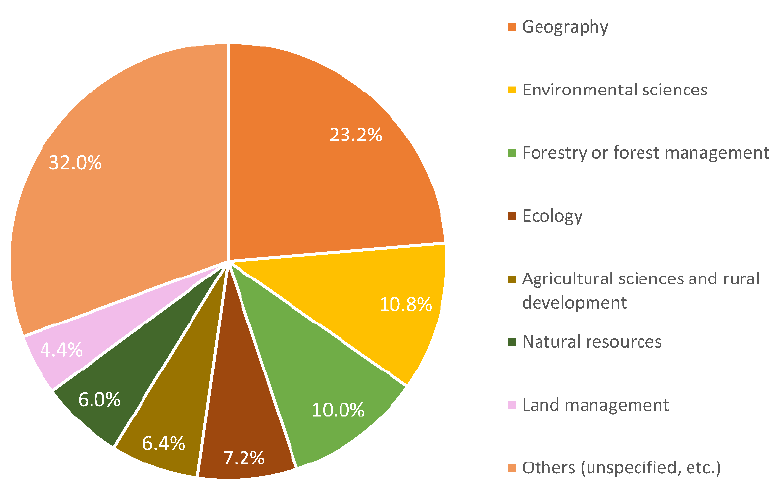
Figure 4. Percentage of articles categorized according to STEPLand steps. Source: own elaboration.